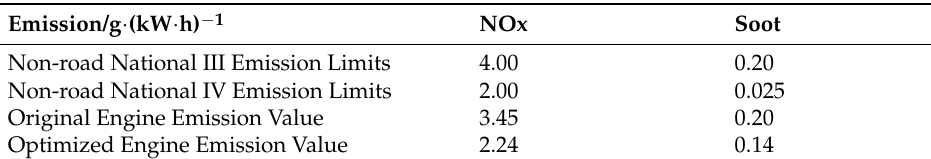
Table 4. Comparison of combustion chamber emissions before and after optimization.